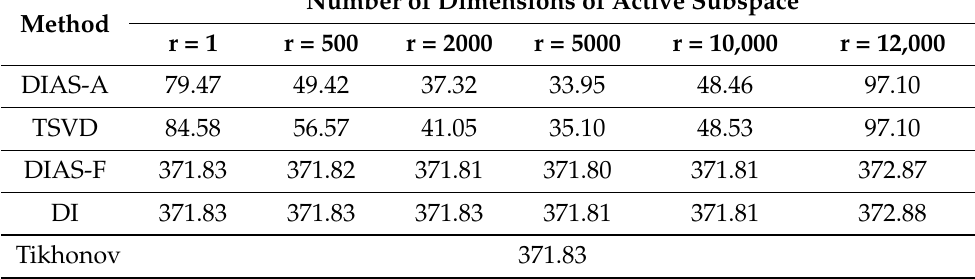
Table 6. Relative error (%) of inverse solutions by DIAS and Tikhonov regularization for underregu- larization case with α = 10 2 , noise level 3%.